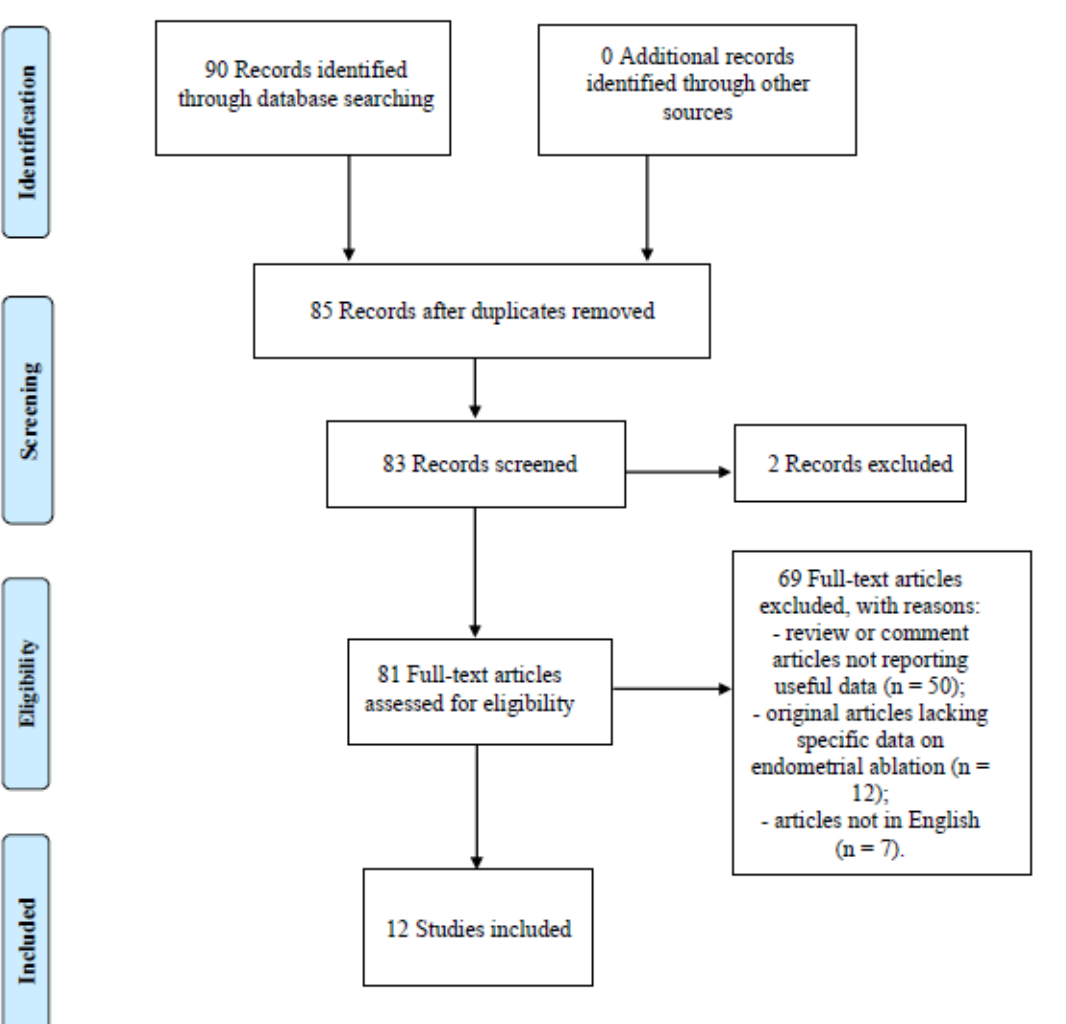
Figure 1. Flow diagram of narrative review search.